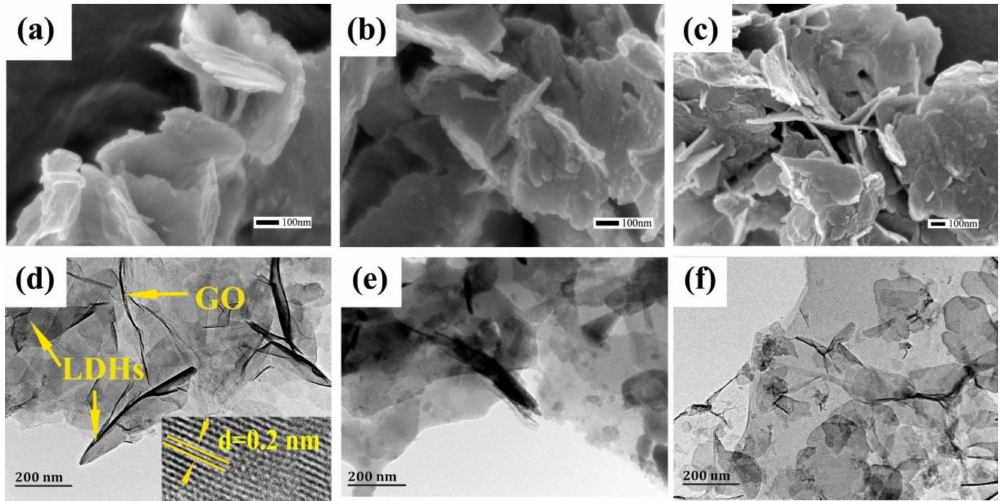
Figure 3. Scanning electron microscopy (SEM) and transmission electron microscopy (TEM) images of ( a , d ) nanocontainer GO/LDHs, ( b , e ) loaded with inhibitors MBT (GO/LDHs-MBT), and ( c , f ) loaded with inhibitors vanadate (GO/LDHs-VO x